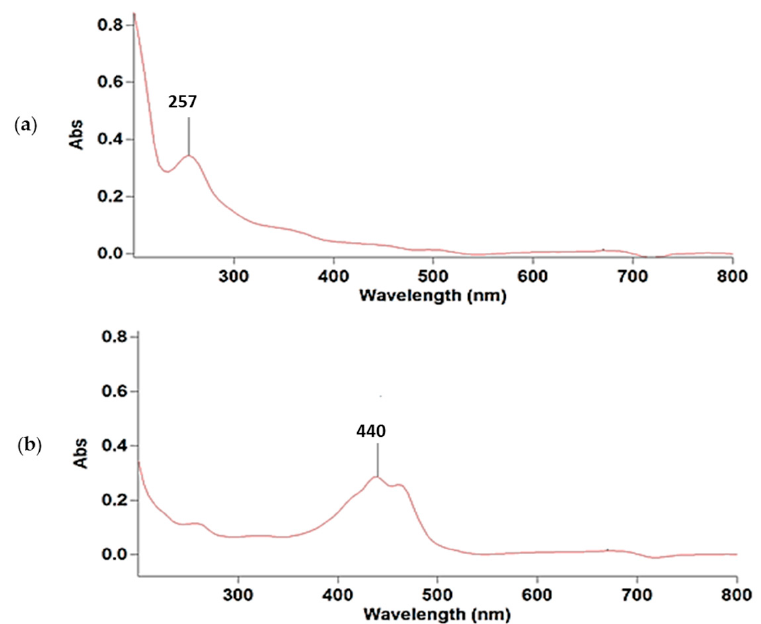
Figure 3. Contour plots of ( a ) volume of saffron extract (mL) and % v / v aqueous can, ( b ) volume of